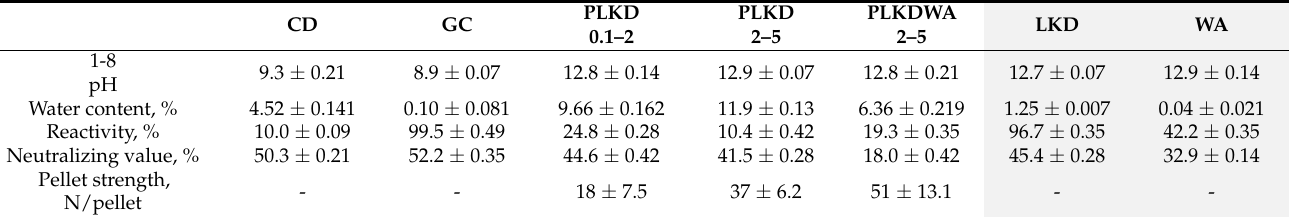
Table 2. Physical properties of liming materials and pelletized